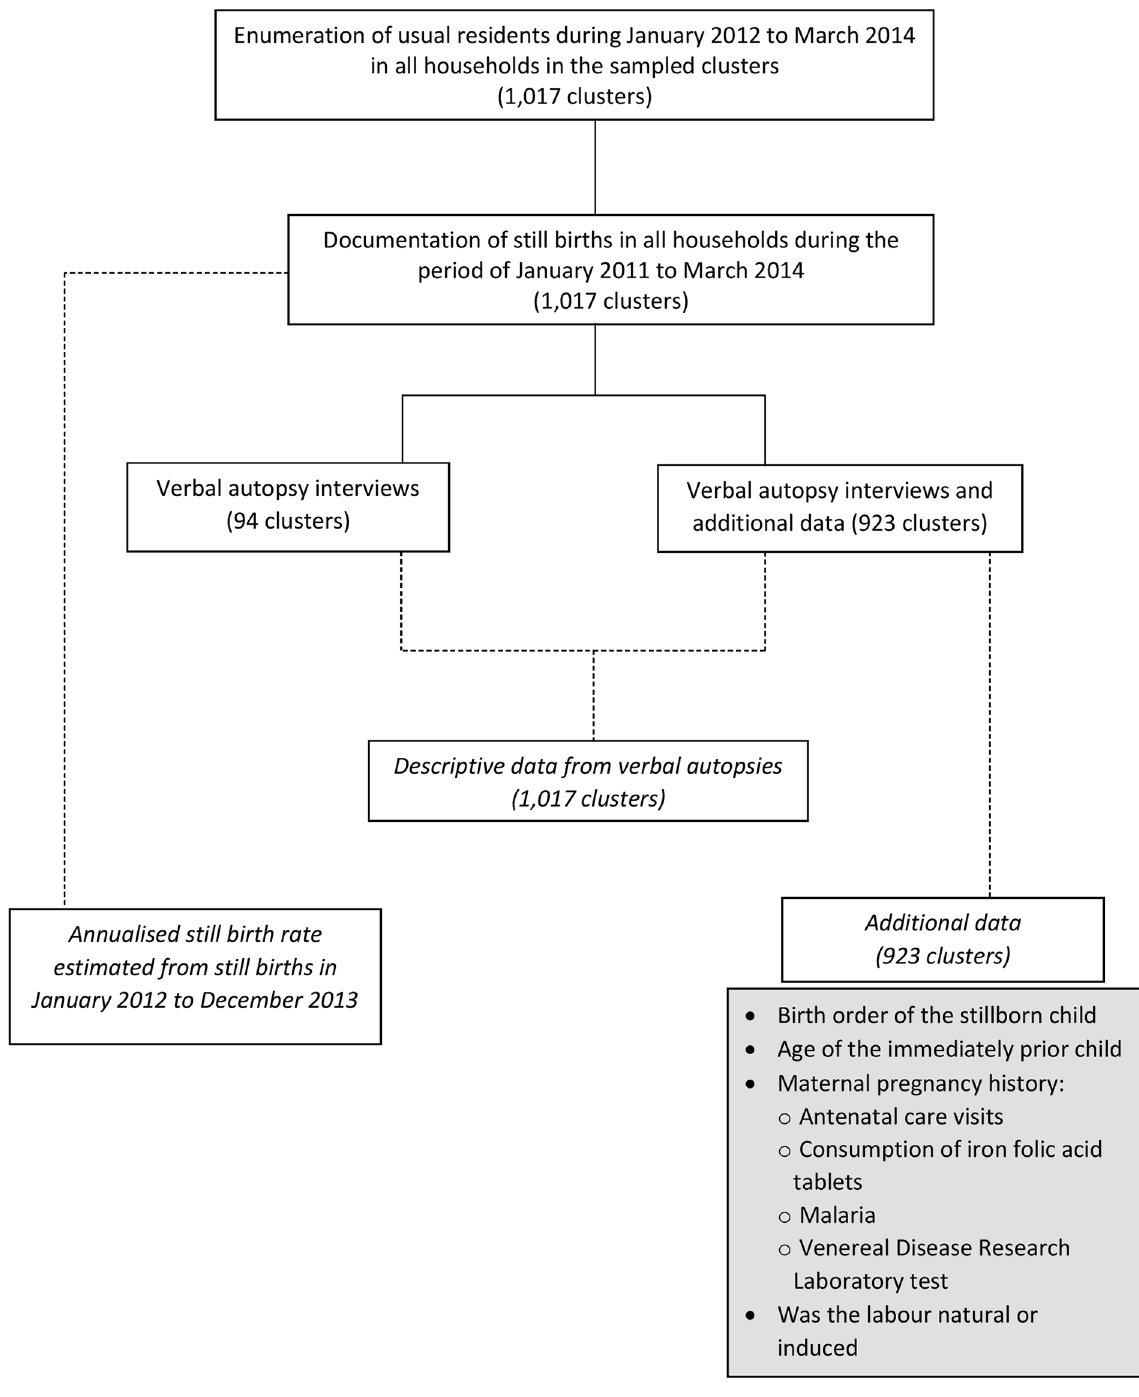
Fig 1. Diagrammatic representation of the data collection process.